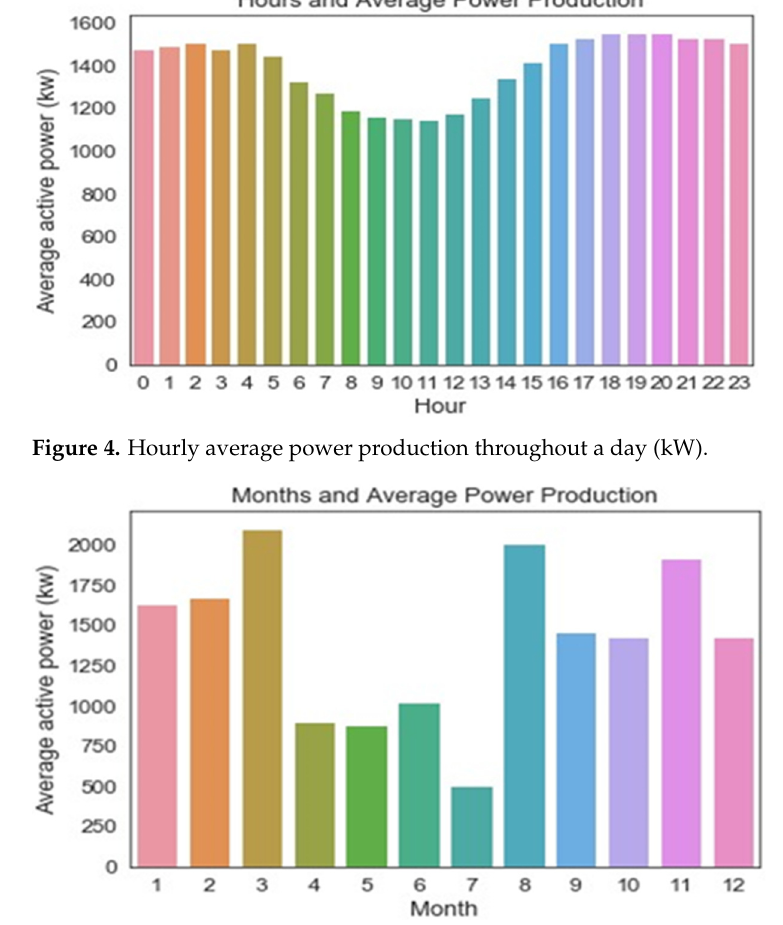
Figure 5. Monthly average power production (kW).